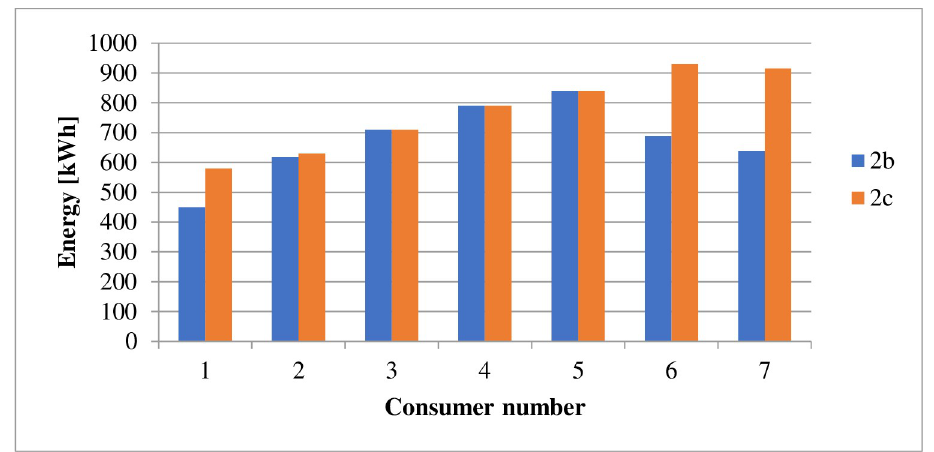
Fig 7. Power curtailed by consumers per day–case 2.